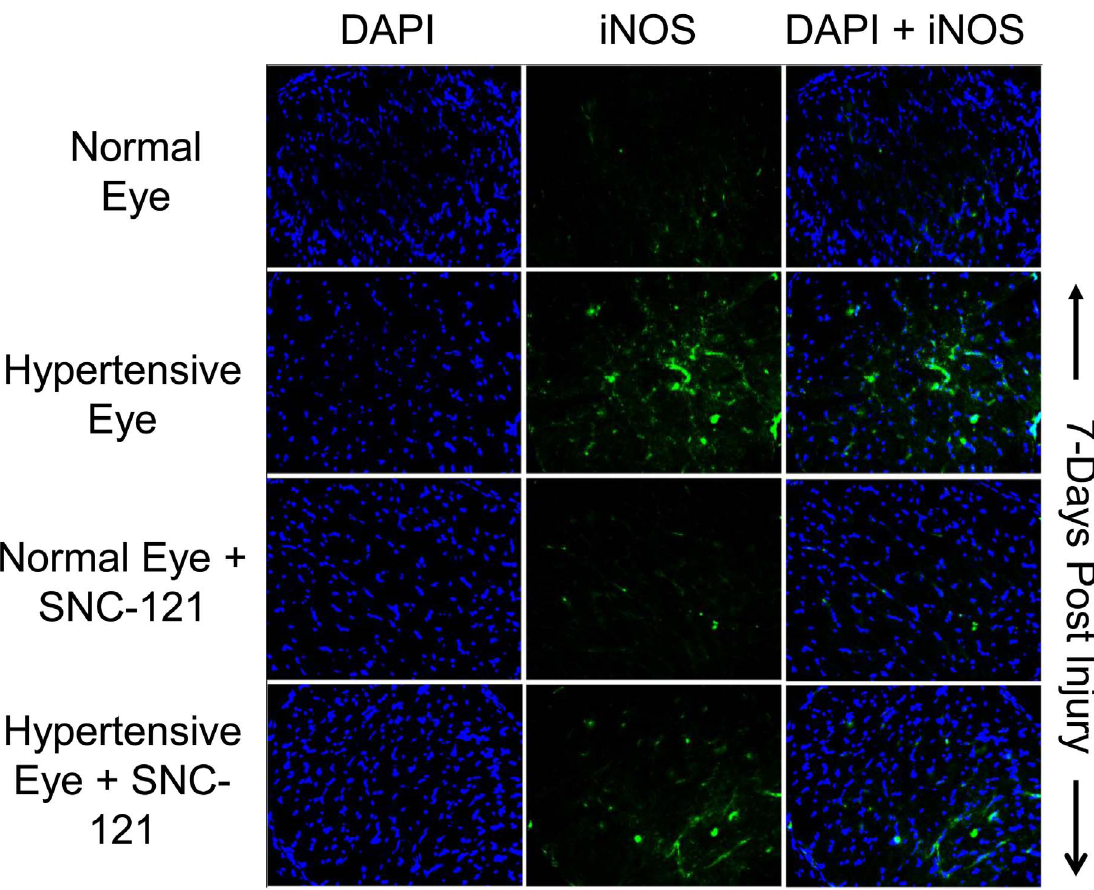
Figure 7. Changes in iNOS expression in glaucomatous optic nerve at 7 days, post injury. The optic nerve (non-myelinated; 2 mm post globe) of Brown Norway rats was removed 7-days post glaucomatous injury. Contralateral optic nerve was used as the normal control. Cryosections were immunostained by anti-iNOS antibodies as indicated horizontally. Ocular treatments are indicated vertically. Green color indicates staining for iNOS and blue nuclei for DAPI. There was no positive staining when primary antibodies were omitted (data not shown). Data shown here are representations of at least four independent experiments. A total of 10 animals were used in this experiment. Comparable staining for iNOS was seen in at least 4 animals in each treatment group.